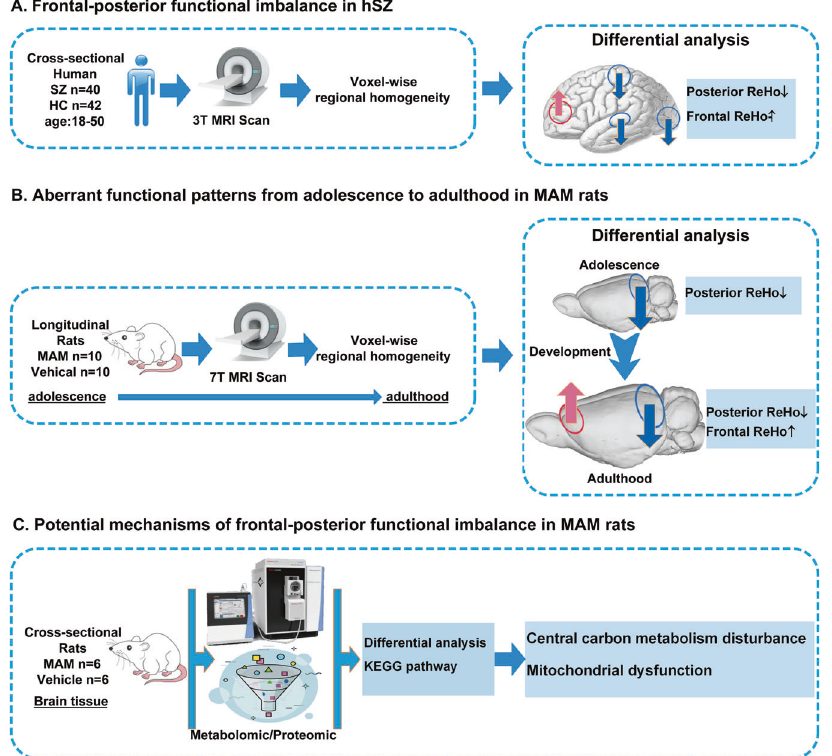
Fig. 1 Flow diagram of the study design. A We con fi rmed the frontal-posterior functional imbalance of SZ by comparison of ReHo using cross-sectional fMRI data of hSZ and HC. The frontal-posterior functional imbalance was characterized by increased frontal (frontal cortices) and decreased posterior (visual and associated cortices) ReHo. B We determined the aberrant function developmental patterns with respect to the timing and localization of major ReHo changes from adolescence to adulthood using longitudinal design in MAM rats. The aberrant function developmental patterns were characterized by primarily decreased posterior ReHo in adolescence and subsequently decreased posterior and increased frontal ReHo in adulthood. C We analyzed brain metabolomic and proteomic pro fi les from a cross-sectional cohort of MAM rats and vehicle rats. Metabolic and proteomic changes in MAM rats suggested the potential mechanisms underlying the ReHo alterations in adulthood, including central carbon metabolism disturbance and mitochondrial dysfunction. SZ schizophrenia, hSZ human with schizophrenia, HC healthy control, fMRI functional magnetic resonance imaging, ReHo regional homogeneity, MAM methylazoxymethanol acetate, KEGG Kyoto Encyclopedia of Genes and